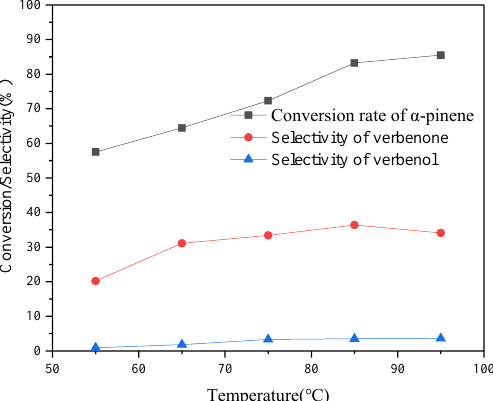
Figure 6. Variation of temperature in the oxidative synthesis of verbenone by α -pinene and TBHP. Reaction conditions: CuAPO-5(0.06) 100 mg, α -pinene 1 mmol, TBHP 2 mmol, TCM 10 mL, reaction time 10 h.